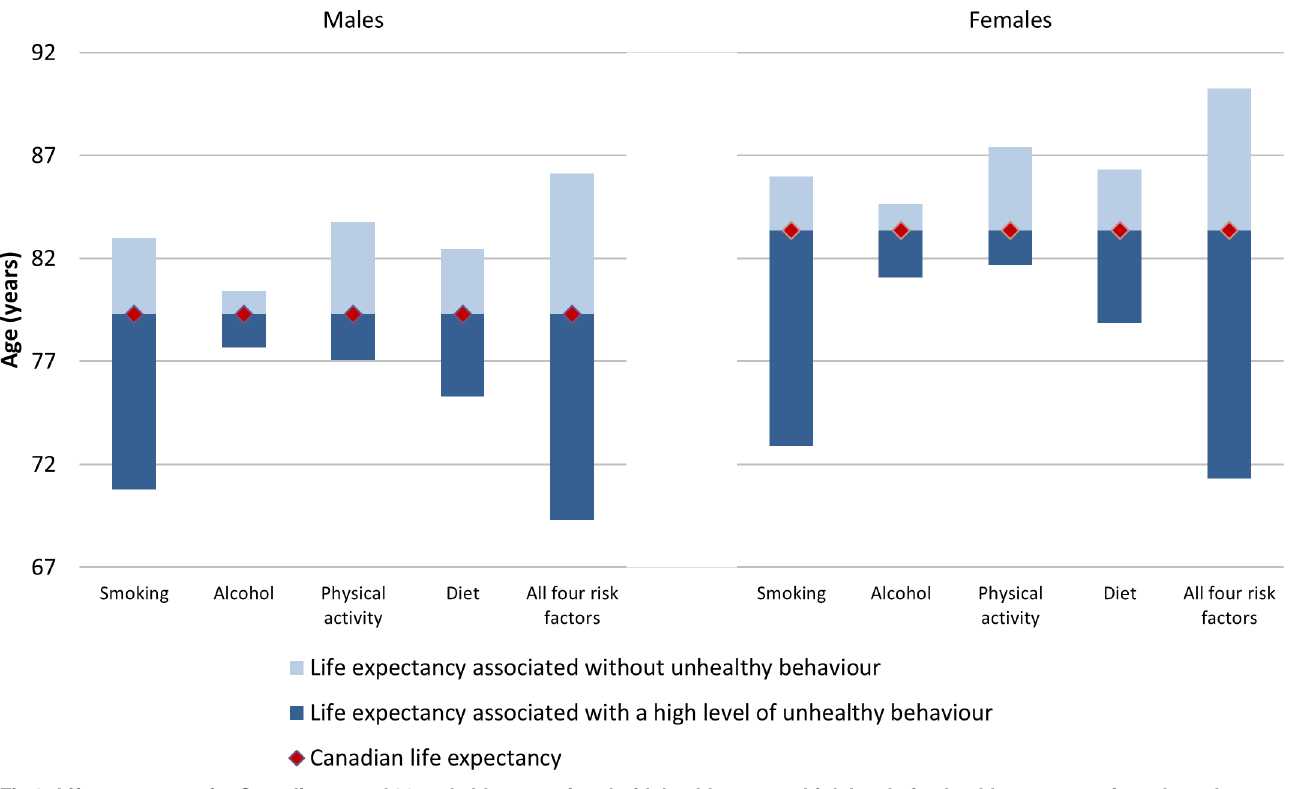
Fig 3. Life expectancy for Canadians aged 20 and older associated with healthy versus high level of unhealthy exposure for selected behaviours, relative to average Canadian life expectancy, 2010. Gain or loss of life expectancy from full MPoRT model (incorporating age, health behaviours, sociodemographic, and disease indicators) applied to Canadian national